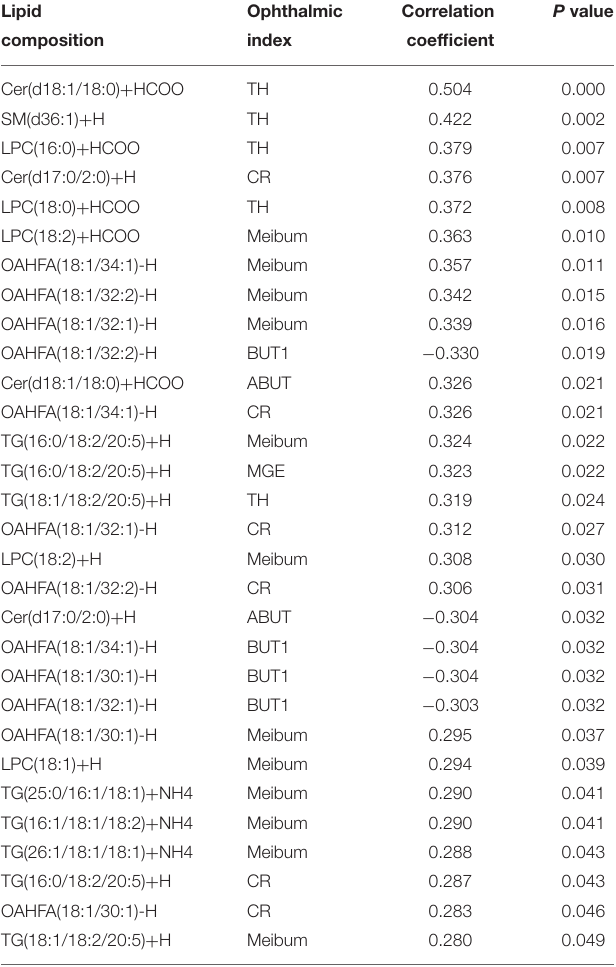
TABLE 5 | Analysis of the correlation between lipid composition and ophthalmic indexes. Lipid Ophthalmic Correlation P value composition